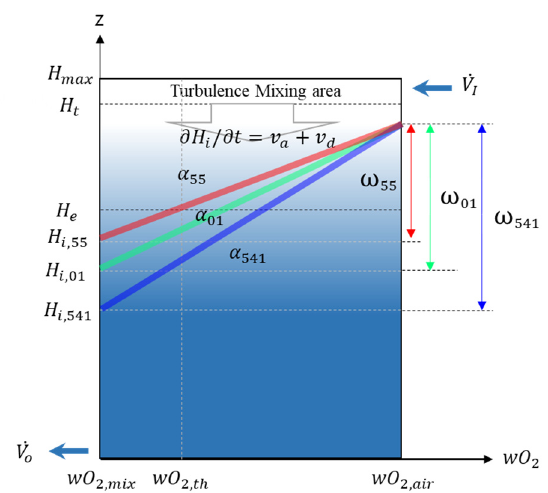
Figure 14. Schematic diagram of O 2 concentration distribution profile reflecting the experimental and numerical analysis results.